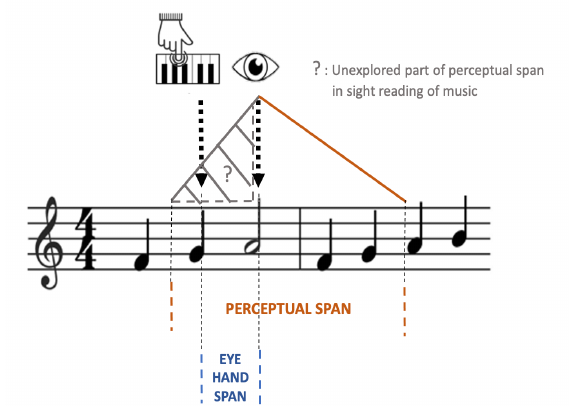
Figure 1. EHS and perceptual span during a sight-reading task Figure 2. Representation of EHS measured in absolute